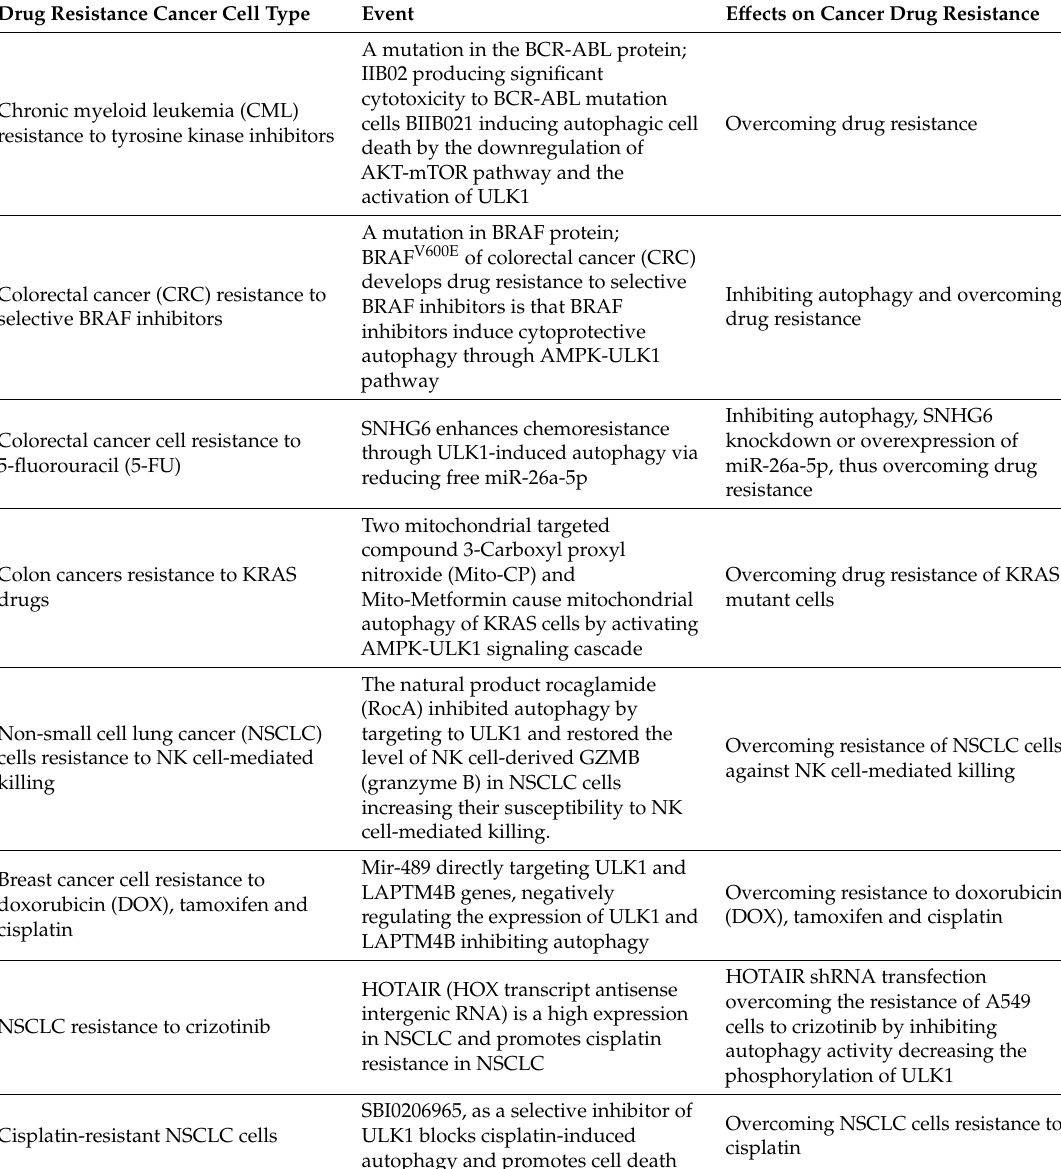
Table 4. Molecular events of ULK1-related cancer drug